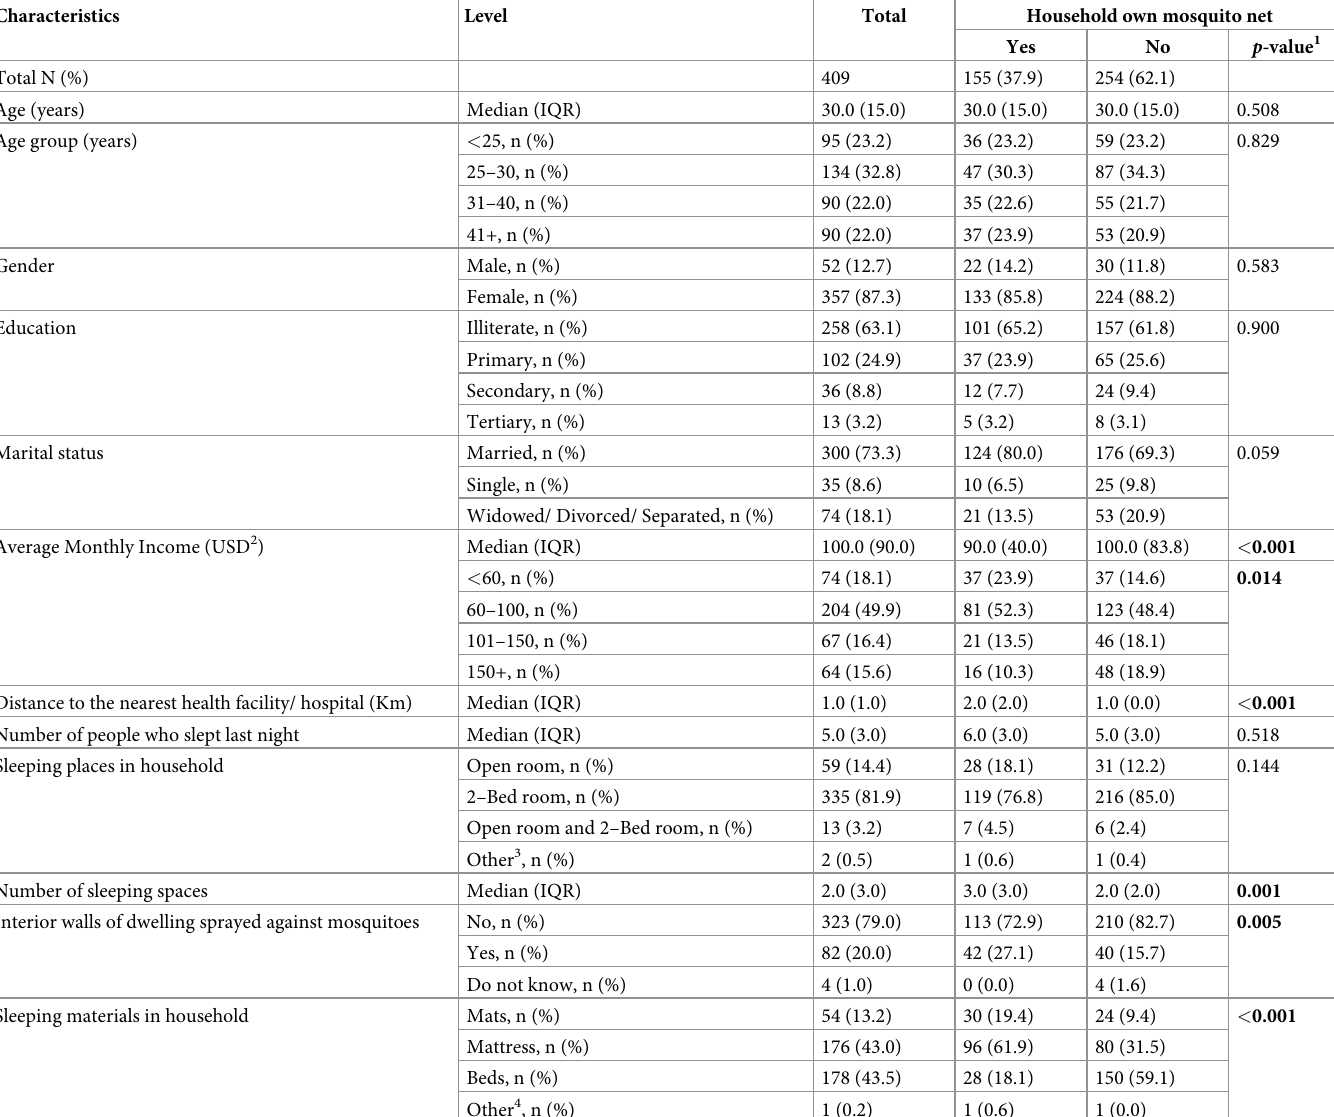
Table 1. Household head’s individual- and household-level characteristics stratified by ownership of LLIN among households surveyed, Mogadishu–Somalia, 2021.